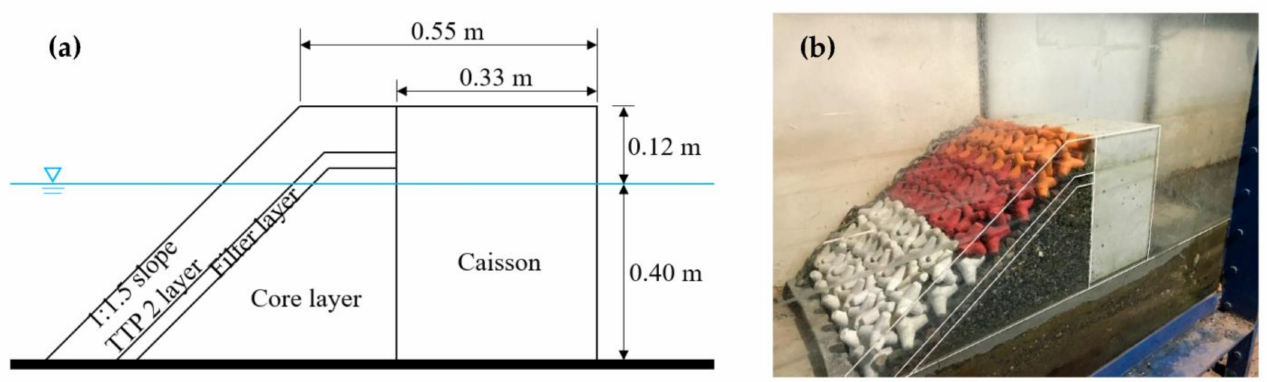
Figure 3. Composite breakwater model: ( a ) the sketch of the breakwater model and ( b ) the picture of the breakwater.